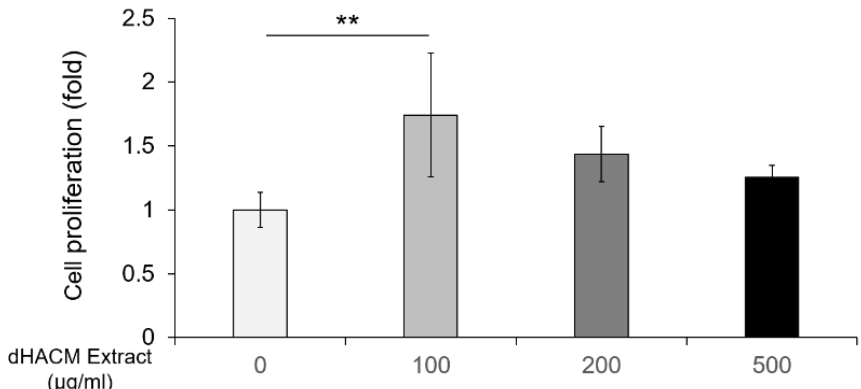
Figure 6. The effect of dHACM on cell proliferation. After incubation with/without dHACM extract for 48 h, the proliferation of rPDLCs was assessed by WST-1. Values are shown as means ± standard deviations ( n = 9). ** p < 0.01, compared to the untreated control, ANOVA with Tukey post-test.